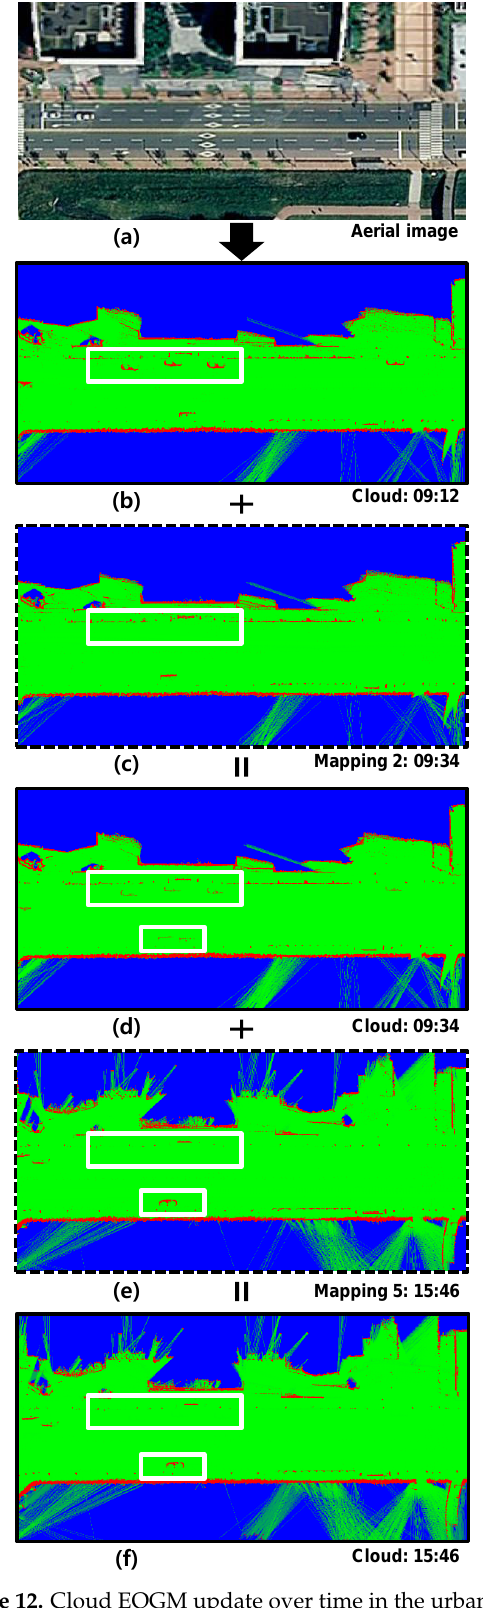
Figure 12. Cloud EOGM update over time in the urban